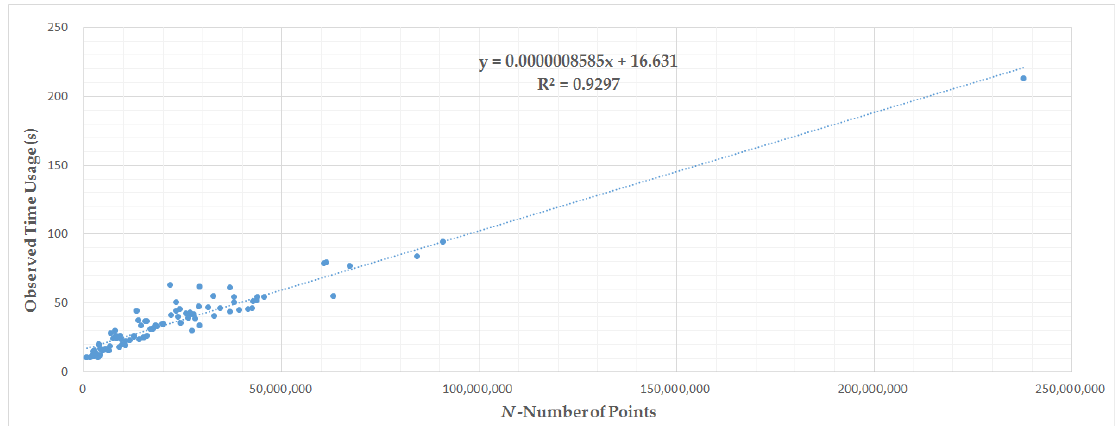
Figure 9. Linear regression of P 4 (This is the relation between N and the time usage in area calculation, where N is the number of vertices).